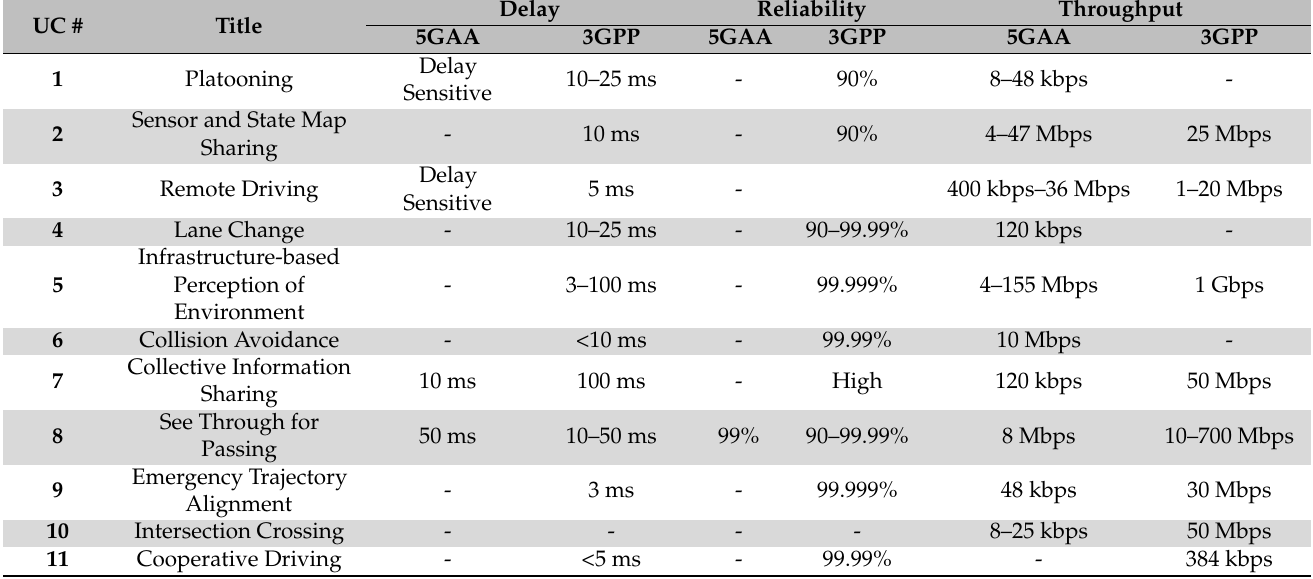
Table 2. V2X use case